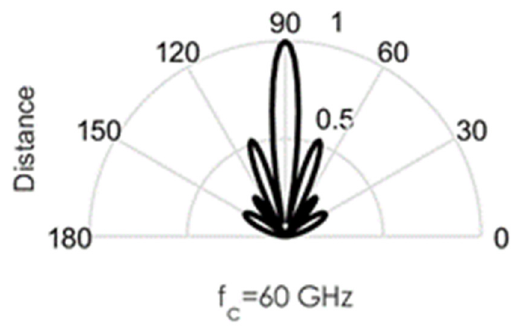
Figure 3. Directional beams produced by Uniform Linear arrays (ULA) operating at 60 GHz; 8 array elements with λ /2-spacing; steering vector A = [4 3 2 1 1 2 3 4].